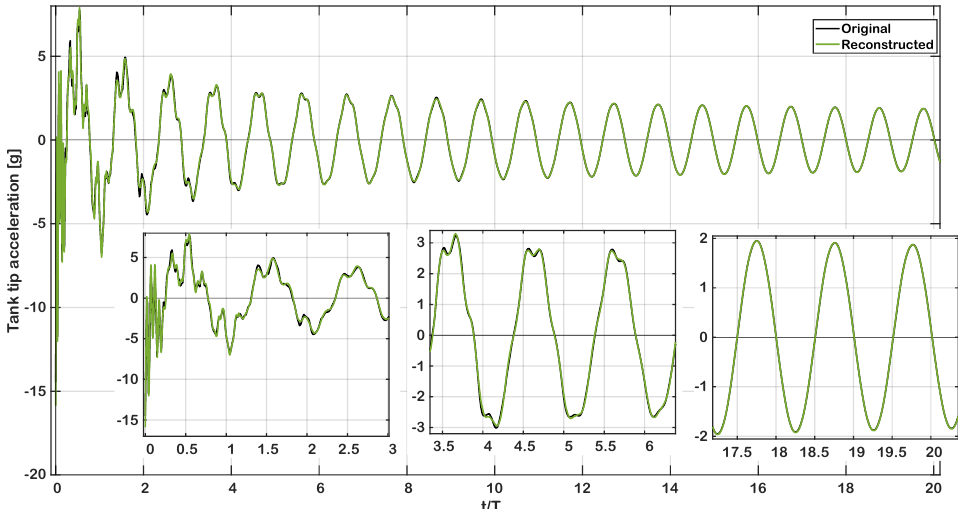
Figure 3. Example of NLS identification result. Original signal is shown in black and the reconstructed signal using the fitted functions is shown in